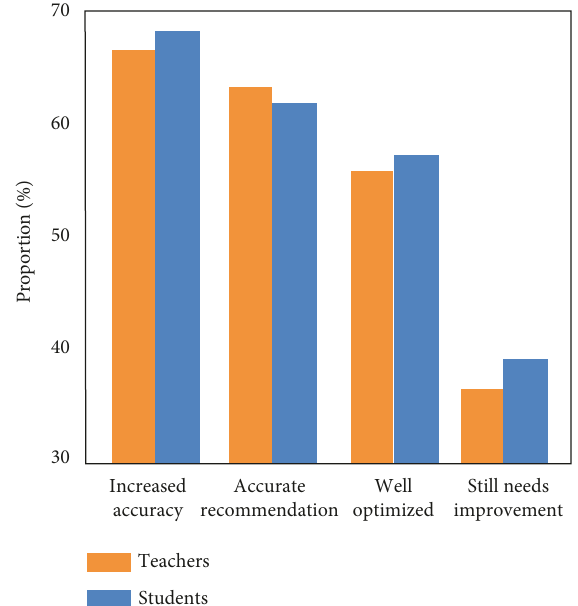
Figure 9: New archives music audio and video teachers and students satisfaction survey results